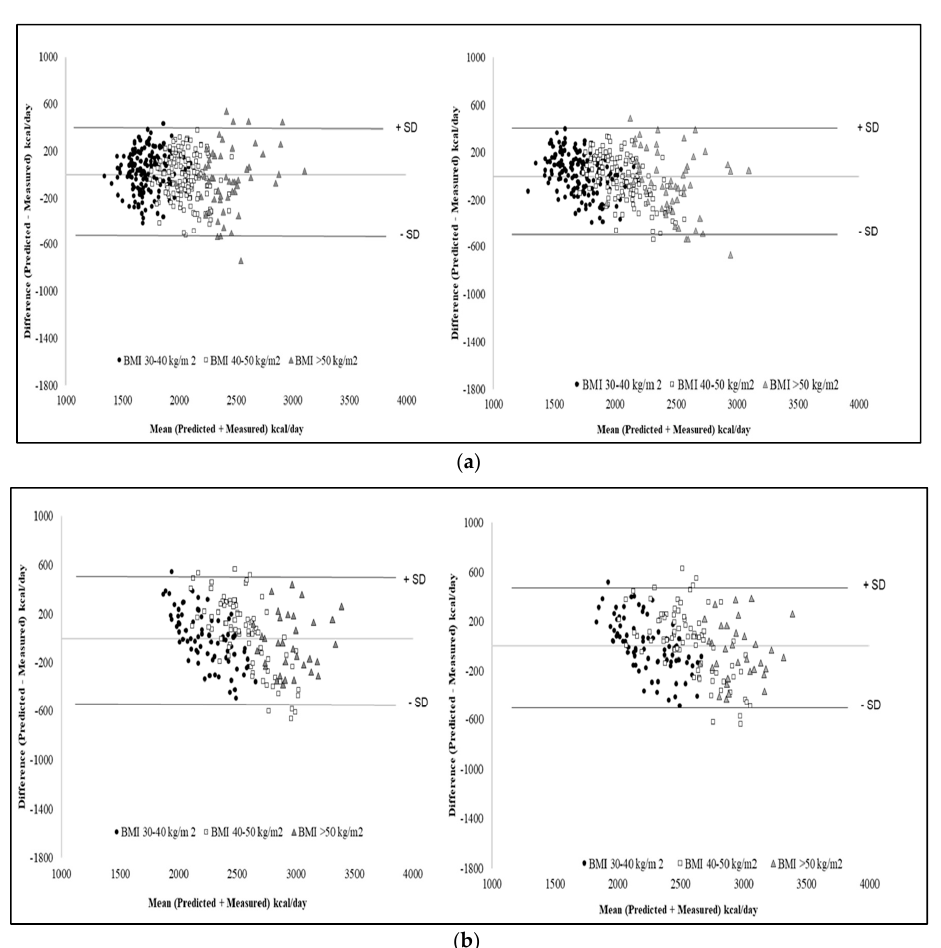
Figure 2. Bland ‐ Altman plots between differences and mean predicted ‐ measured REE using the new predictive equations in 195 males ( a : Equations (1) and (3)) and 350 ( b : Equations (2) and (4)) females predictive equations in 195 males ( a : Equations 1 and 3) and 350 ( b : Equations 2 and 4) females with with obesity. The dotted lines represent 2 SDs from the mean (limits of obesity. The dotted lines represent 2 SDs from the mean (limits of agreement).